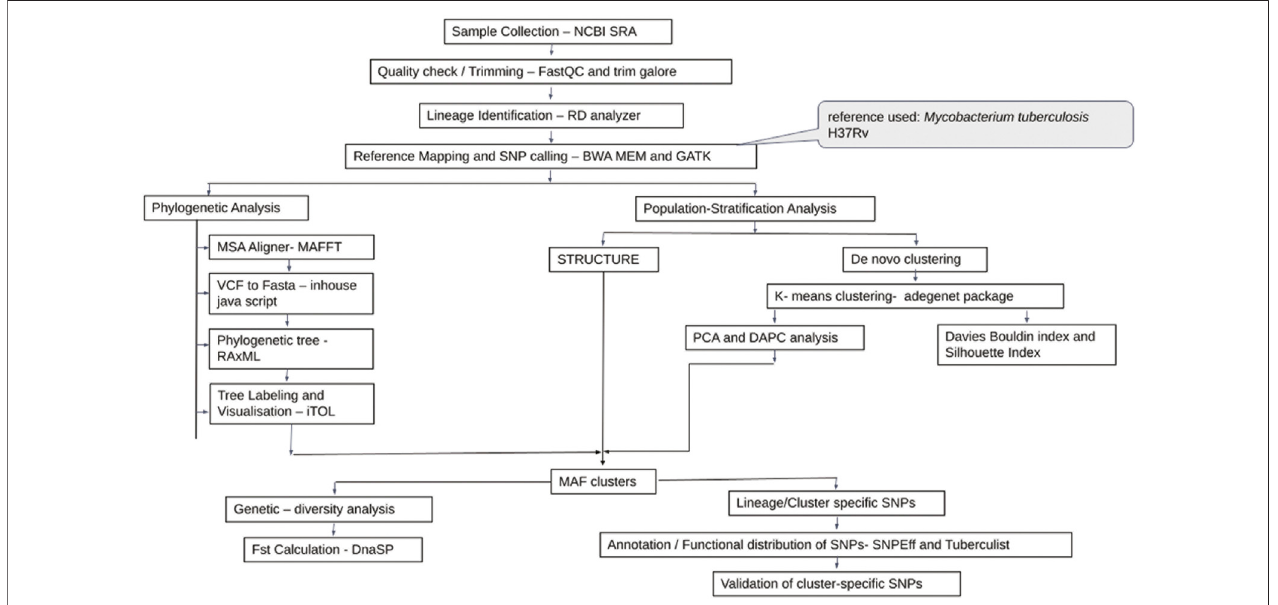
FIGURE 1 | Flowchart for genetic diversity analysis of Mycobacterium africanum